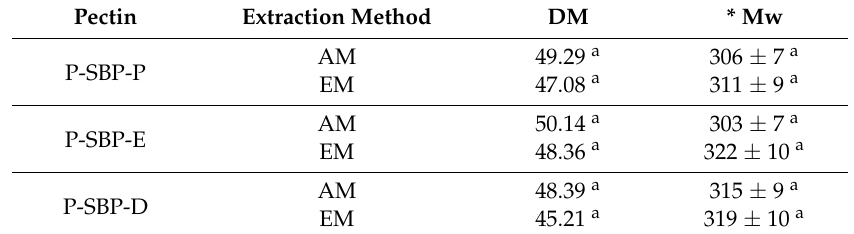
Table 3. Degree of methoxylation (DM) (%), and molecular weight (Mw)(kDa) of pectin extracted from sugar beet by-products. Pectin Extraction Method DM * Mw P-SBP-P